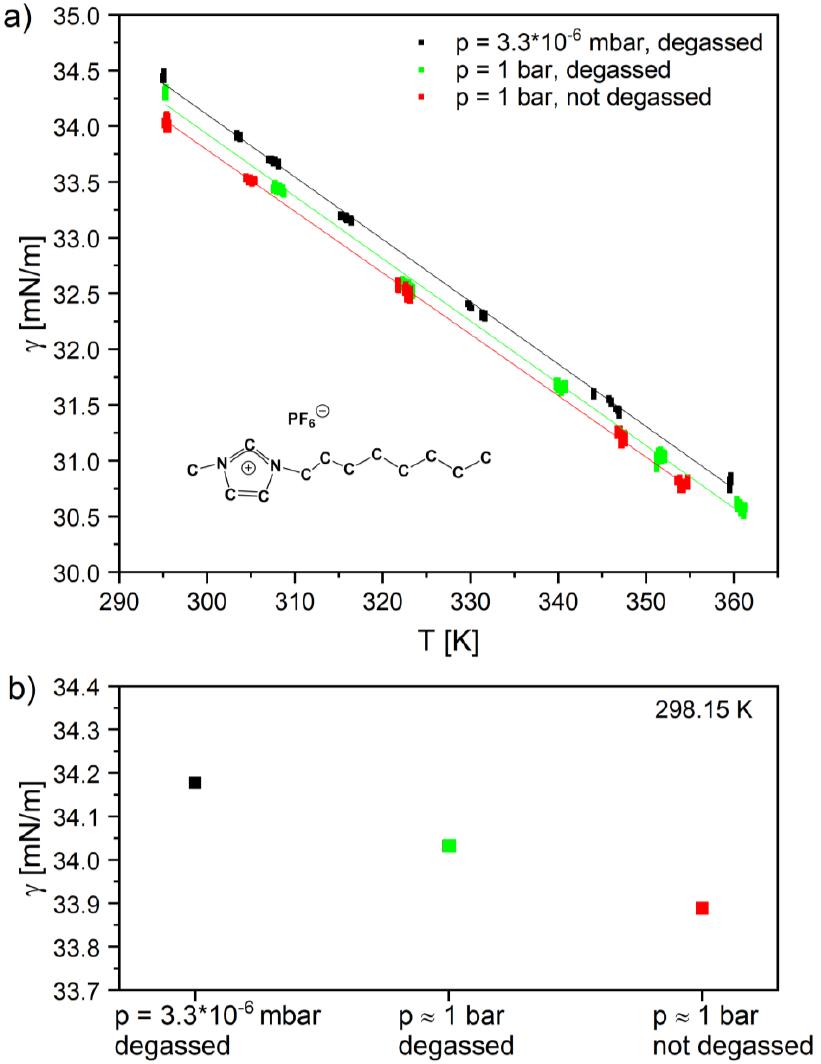
Figure 7. Surface tension of [C 8 C 1 Im][PF 6 ] (see inset) in vacuum and in air (p ≈ 1 bar) under degassed and non-degassed conditions at different temperatures ( a ) using the temperature-dependent density of dried [C 8 C 1 Im][PF 6 ] from Ref. [52] (ST values are provided in Table S1 of SI). ( b ) Calculated ST values at room temperature (298.15 K) for the three different conditions (see also Table 2) based on the linear fits of (a) using Equation